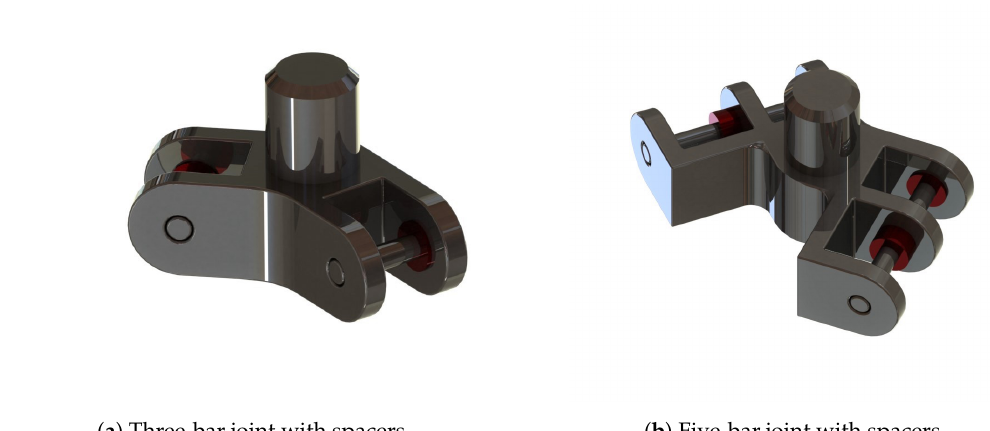
Figure 4. Joints of the Large Deployable Reflectors (LDR) opening system.